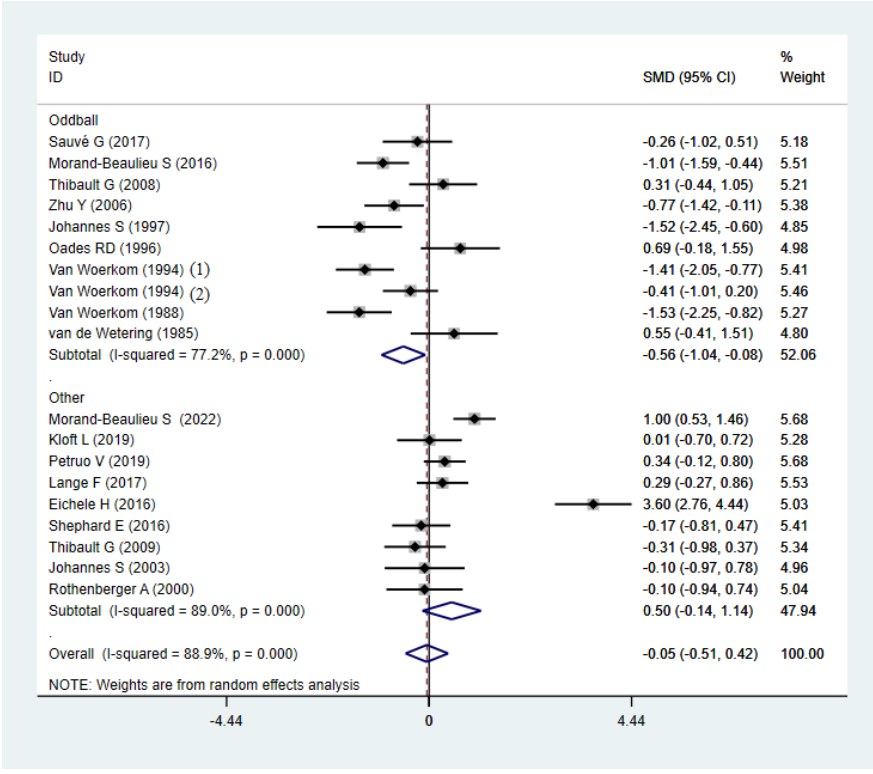
Figure 8. Subgroup analysis of P3b amplitude in TD patients and HCs (oddball paradigm and other paradigms). SMD: Standard Mean Difference; CI: confidence interval.